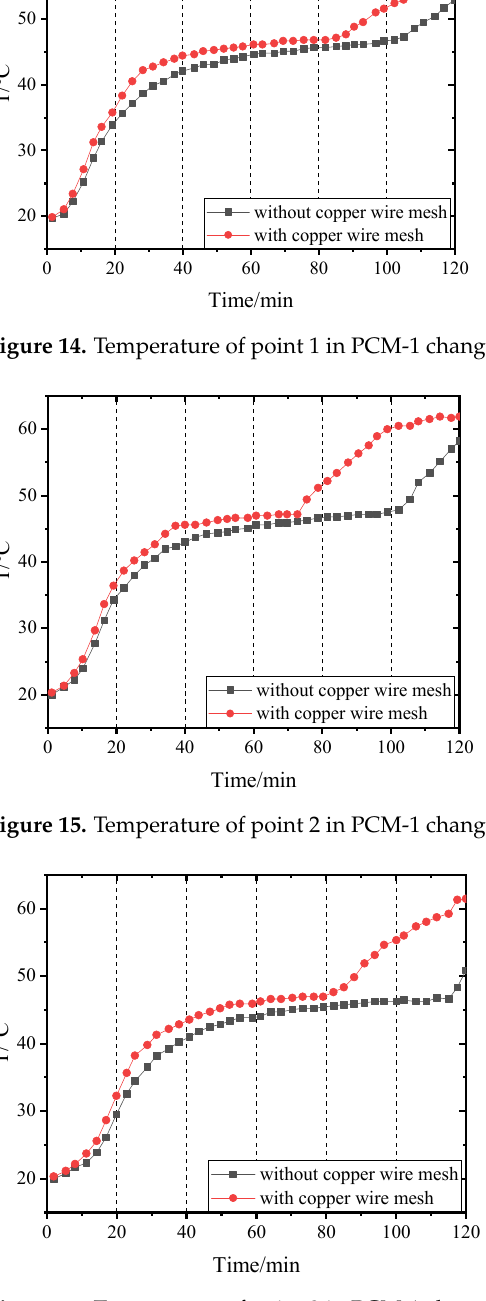
Figure 16. Temperature of point 3 in PCM-1 changing with time.